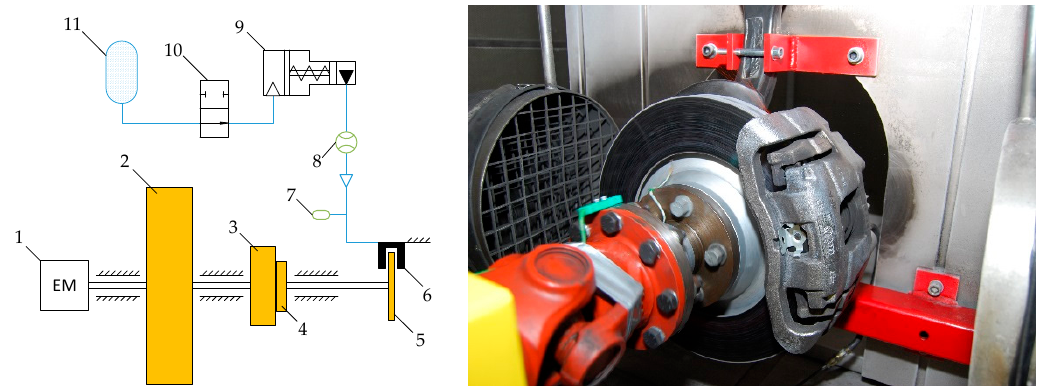
Figure 3. Brake dynamometer with climatic chamber, employed for experimental tests at the Technische Universität Ilmenau. 1—Drive Motor, 2—Flywheels, 3—Inertial hub, 4—Torque sensor, 5—Brake disc, 6—Brake calliper, 7—Brake pressure sensor, 8—Flow meter, 9—Master cylinder, 10—Compressed air hydraulic actuator, 11—Pressure accumulator.